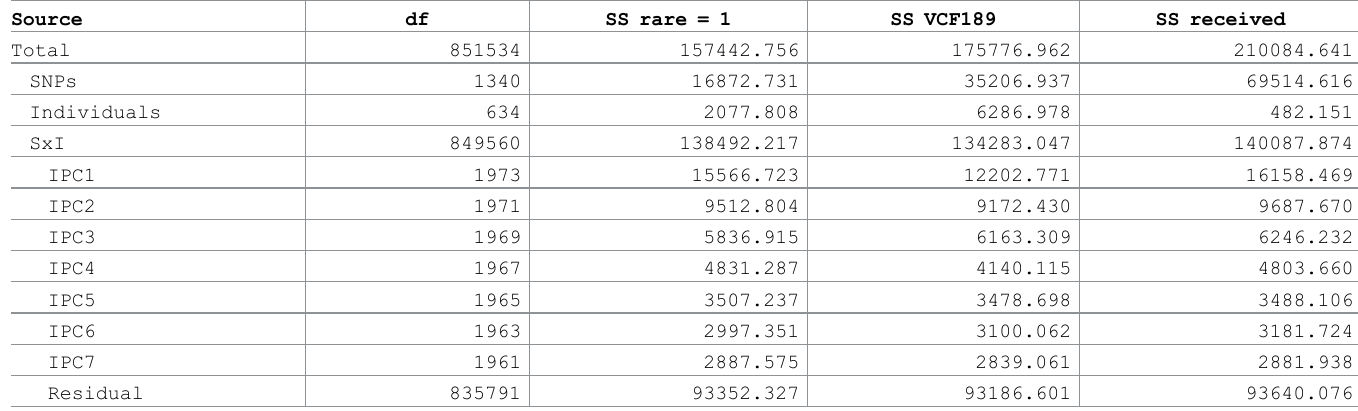
Table 1. ANOVA table for DC-PCA of SNP data on oats using three SNP codings: Rare = 1 (and common = 1 is identical), VCF with oat line 189 as the reference genome, and the data as received. Both VCF189 and the received data are instances of SNP coding mixed.